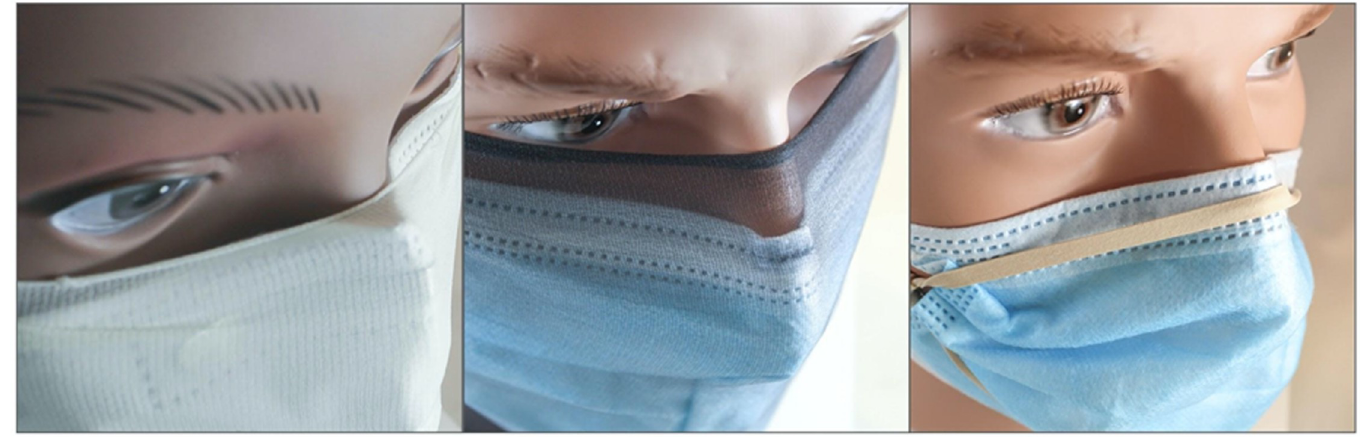
Fig 5. Many fit hacks were unable to fix fit issues around the nose bridge. This impacted wearers with more prominent noses and provided an example of one facial feature critical to the efficacy of fit hacks.